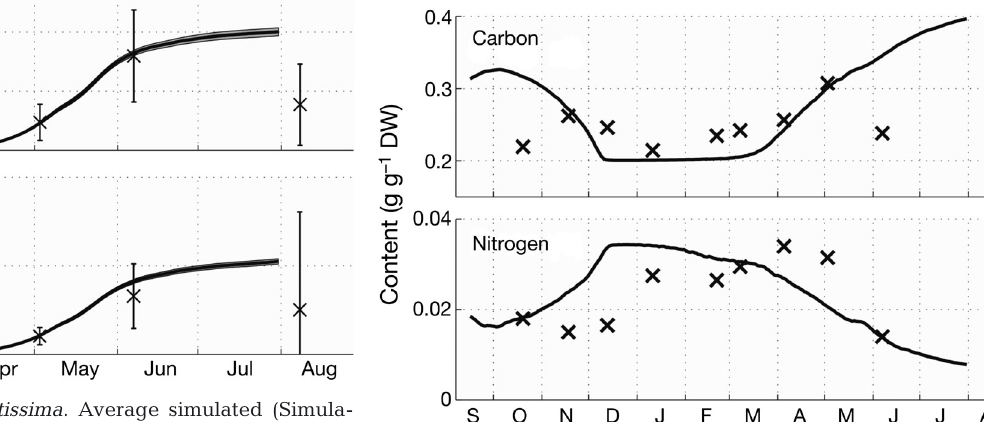
Fig. 11. Saccharina latissima . Simulated (Simulation B Aug,N , continuous line) and sampled (crosses) carbon and nitrogen content for the plants at the fish farm station at 5 m depth. DW: dry